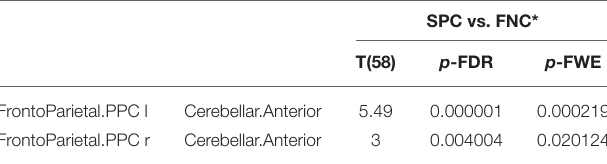
TABLE 4 | The increased functional connectivity in older females observed only in SPC analysis, not found in FNC method. SPC vs. FNC* T(58) p -FDR p -FWE FrontoParietal.PPC l Cerebellar.Anterior 5.49 0.000001 0.000219 FrontoParietal.PPC r Cerebellar.Anterior 3 0.004004